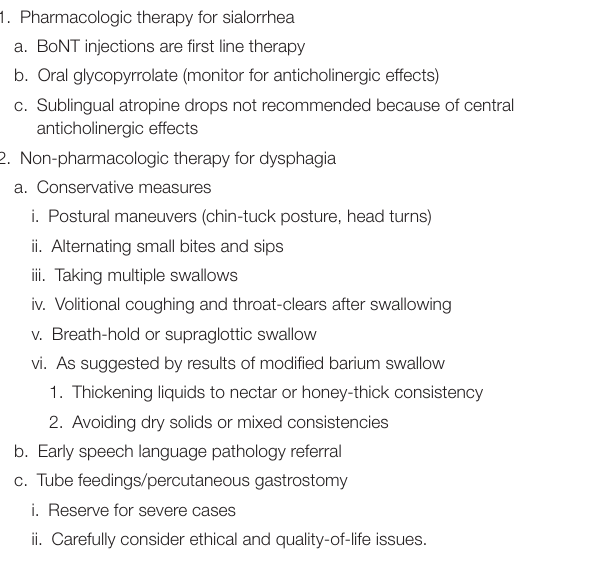
TABLE 8 | Management of sialorrhea and dysphagia in